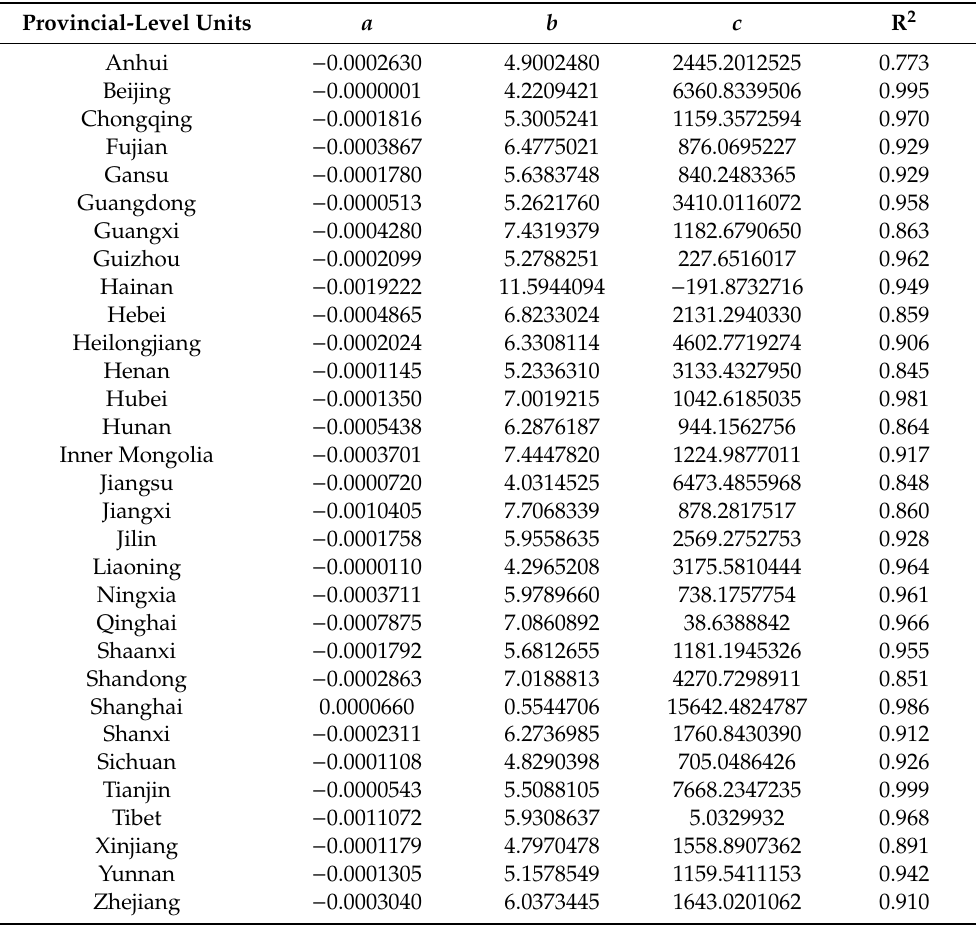
Table A3. Regression parameters of correction model between DMSP / OLS data and NPP / VIIRS